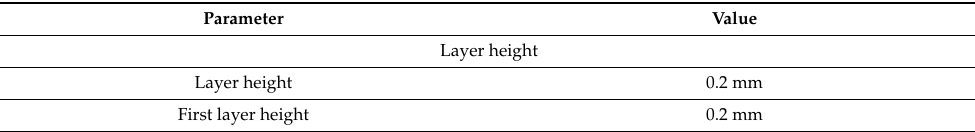
Table 2. Selected 3D printer